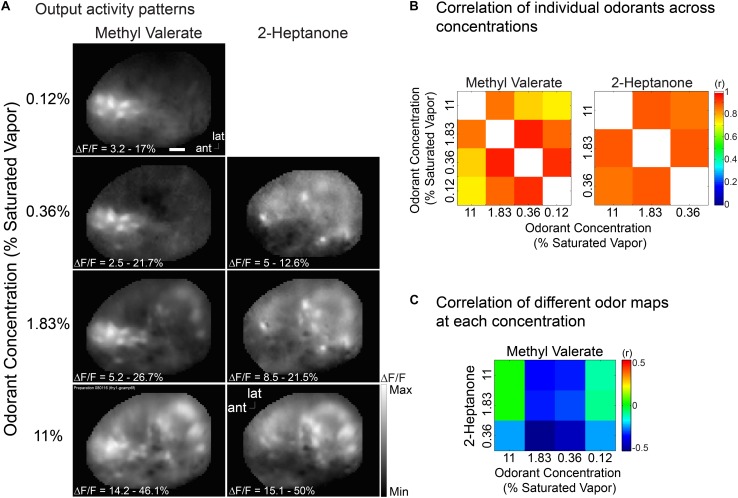
Output maps are relatively concentration invariant, but they are odorant specific. (A) Output maps in response to two odorants, methyl valerate and 2-heptanone, presented at several concentrations. (B,C) Output map correlations evoked by the same (B) and different (C) odorant. The output maps have a much higher correlation for the same odor than for different odors. This example is from a Thy1-GCaMP6f transgenic mouse in which GCaMP6f is selectively expressed in bulb output neurons (Dana et al., 2014). Similar results were obtained in two other preparations using Pcdh21-Cre transgenic mice. Scale bar in a 250 μm. ant, anterior; lat, lateral. Modified from Storace and Cohen (2017).